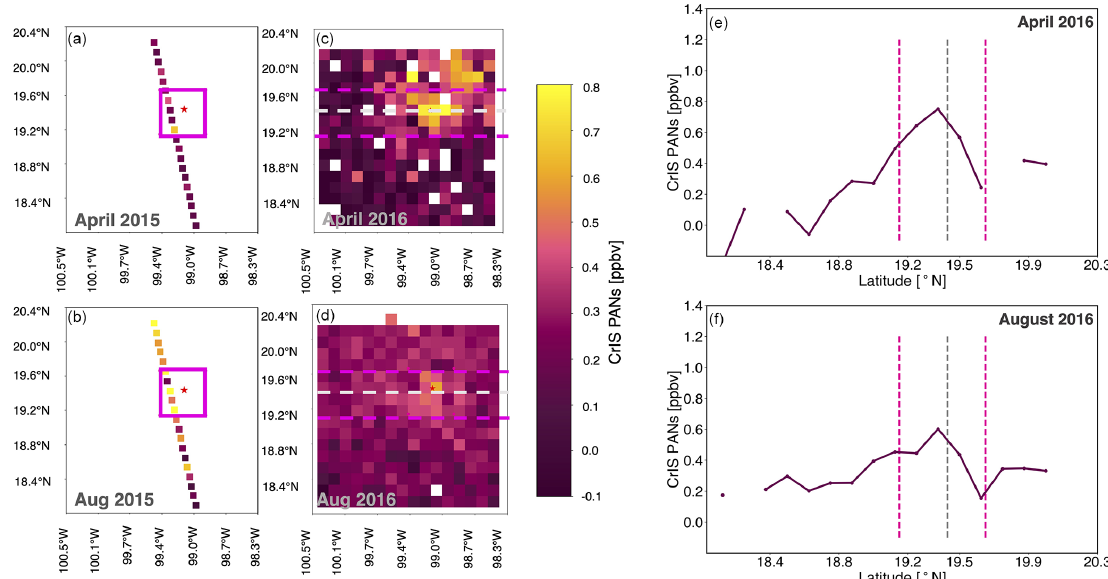
Figure 3. Maps demonstrating PANs enhancements around urban Mexico City. Monthly mean TES transects ( n = 2) are shown for (a) April and (b) August 2015, and monthly averaged gridded CrIS PANs are shown for (c) April and (d) August 2016. CrIS PANs are plotted as a function of latitude for (e) April and (f) August. The latitude bounds of the urban Mexico City box shown in (a) – (b) and Fig. 1 are denoted by pink dashed lines in (c) – (f) . The Mexico City center is denoted by gray dashed lines. White pixels show grid boxes with data that have been filtered out.